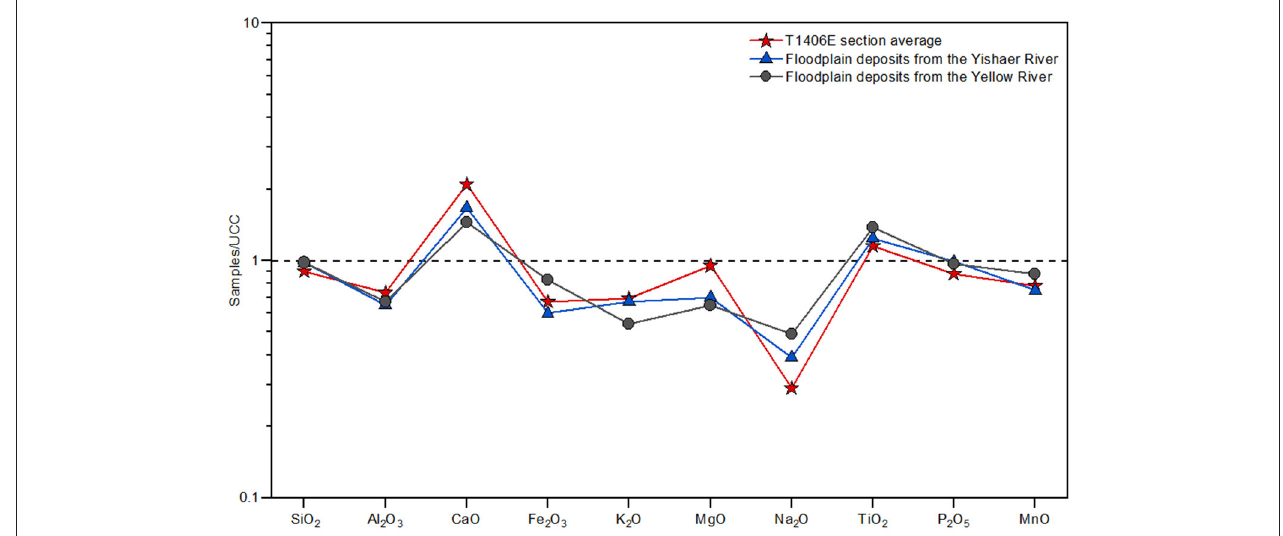
FIGURE 4 | Upper continental crust (UCC)-normalized abundances of the major elements in coarse sand sediments from section T1406E and nearby modern floodplain deposits of the Yellow and Yishaer